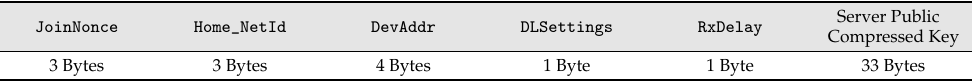
Table 6. Join-Accept type 1 message.